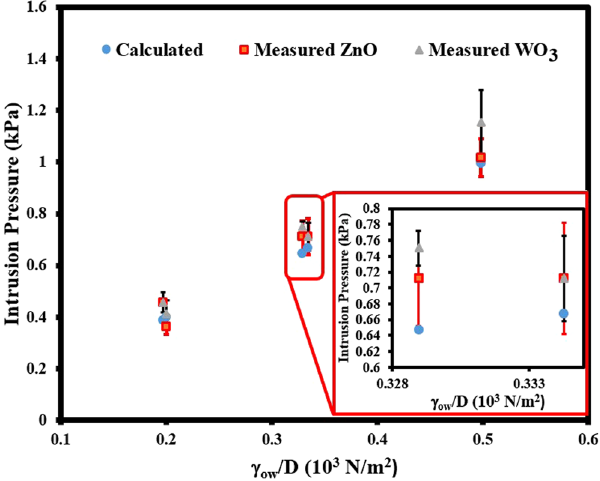
Figure 5. The intrusion pressure of ZnO and WO 3 coated mesh with different pore sizes. The measured value was determined by measuring the maximum hydrostatic pressure and the calculated value was obtained using equation in the manuscript. From these graphs, we can see that the experimental data is statistically in agreement with the calculated